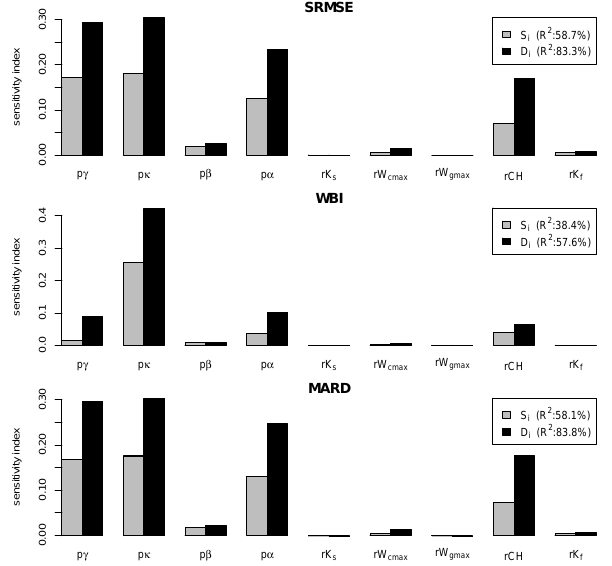
Figure 4. Multiobjective sensitivity analysis result based on the SDP method.